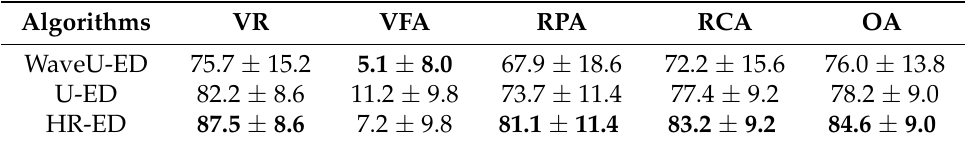
Table 3. Comparison of different singing voice separation methods for VME on MIR1k dataset.